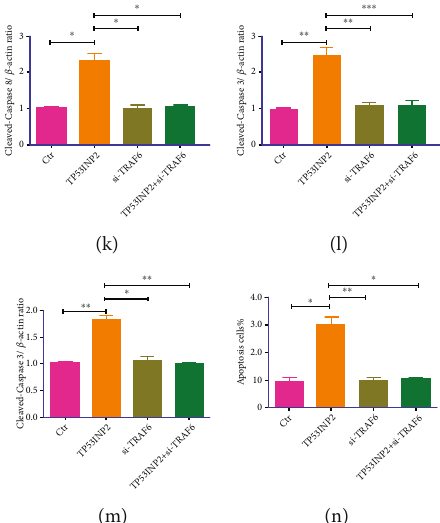
Figure 11: Overexpression of TP53INP2 promoted cell apoptosis via caspase-8/TRAF6 pathway in ACHN cells. (a) and (b) Both mRNA levels of caspase-8 and TRAF6 were detected with qRT-PCR in TP53INP2-treated ACHN cells. (c) and (d) The protein levels of both caspase-8 and TRAF6 were evaluated with western blot. (e) Overexpression of TP53INP2 upregulated both expressions of caspase-8 and TRAF6, which was veri fi ed with immuno fl uorescence. (f) ACHN cells expressing FLAG-TRAF6 and TP53INP2 were immunoprecipitated with FLAG resin, and immunocomplexes were subjected to western blot analysis with anti-FLAG, anti-TP53INP2, and anti-caspase-8 antibody. (g) and (h) TRAF6 silence was transiently transfected into the ACHN cell lines. The relative mRNA level and protein level of TRAF6 was estimated with qRT-PCR and western blot. (i) and (k) – (m) Protein levels of cleaved caspase-3, cleaved caspase-8, and cleaved PARP were measured in cells administrated with TP53INP2, siTRAF6, and TP53INP2+siTRAF6. (j) and (n) Flow cytometry was accomplished for the detection on the apoptosis rate in di ff erent groups. Data were presented as mean ± SD of three or four independent experiments. ∗ P < 0 : 05 ; ∗∗ P < 0 : 01 ; ∗∗ P < 0 : 001